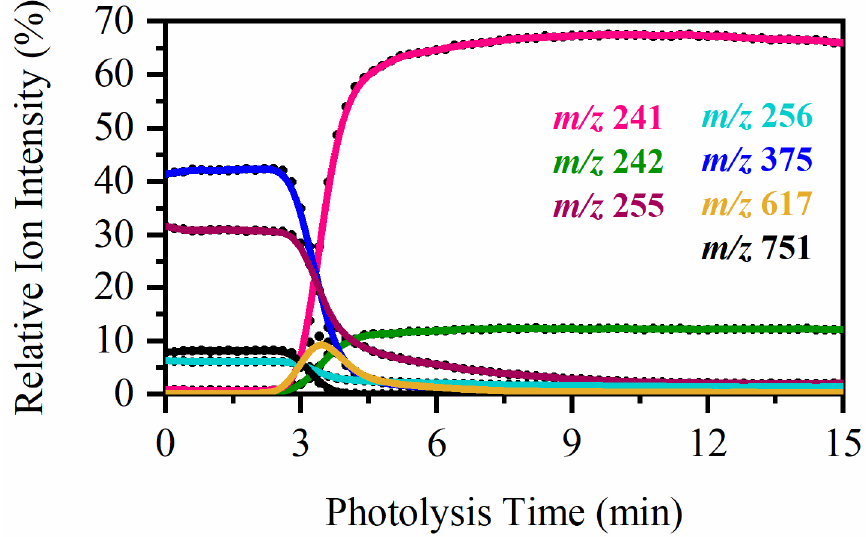
Figure 9. Relative ion intensity plot highlighting the solution-phase photofragment ions of aqueous [RF − H] − produced over a 15 min interval of irradiation at 365 nm (3.4 eV) when delivered via ESI-MS in the negative ion mode. The curved lines included with the data points are a three-point adjacent average of such data points and are extracted from an average of 3 repeat runs. The production curves of the minor solution-phase photofragments are illustrated in Figure S4.